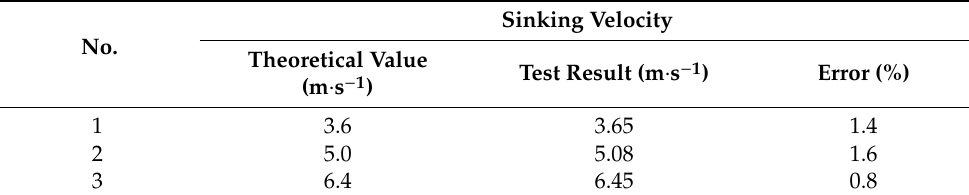
Table 2. Comparison of theoretical value and test result of hanging basket sinking velocity.